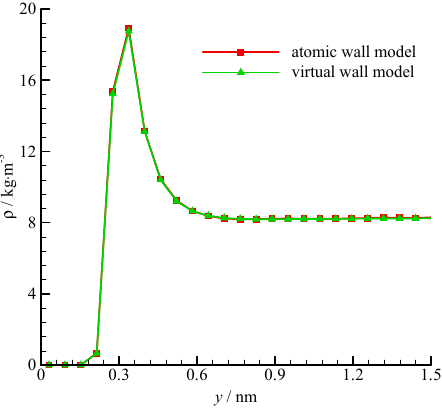
Figure 3. Fluid density profiles of the atomic and virtual wall MD simulations near the wall in Poiseuille flow, using the dimensional wall distance.